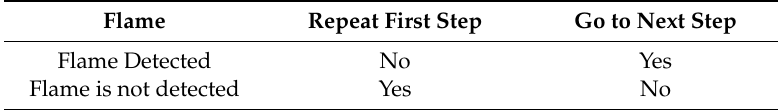
Table 5. Rules for FMWS (according to flame